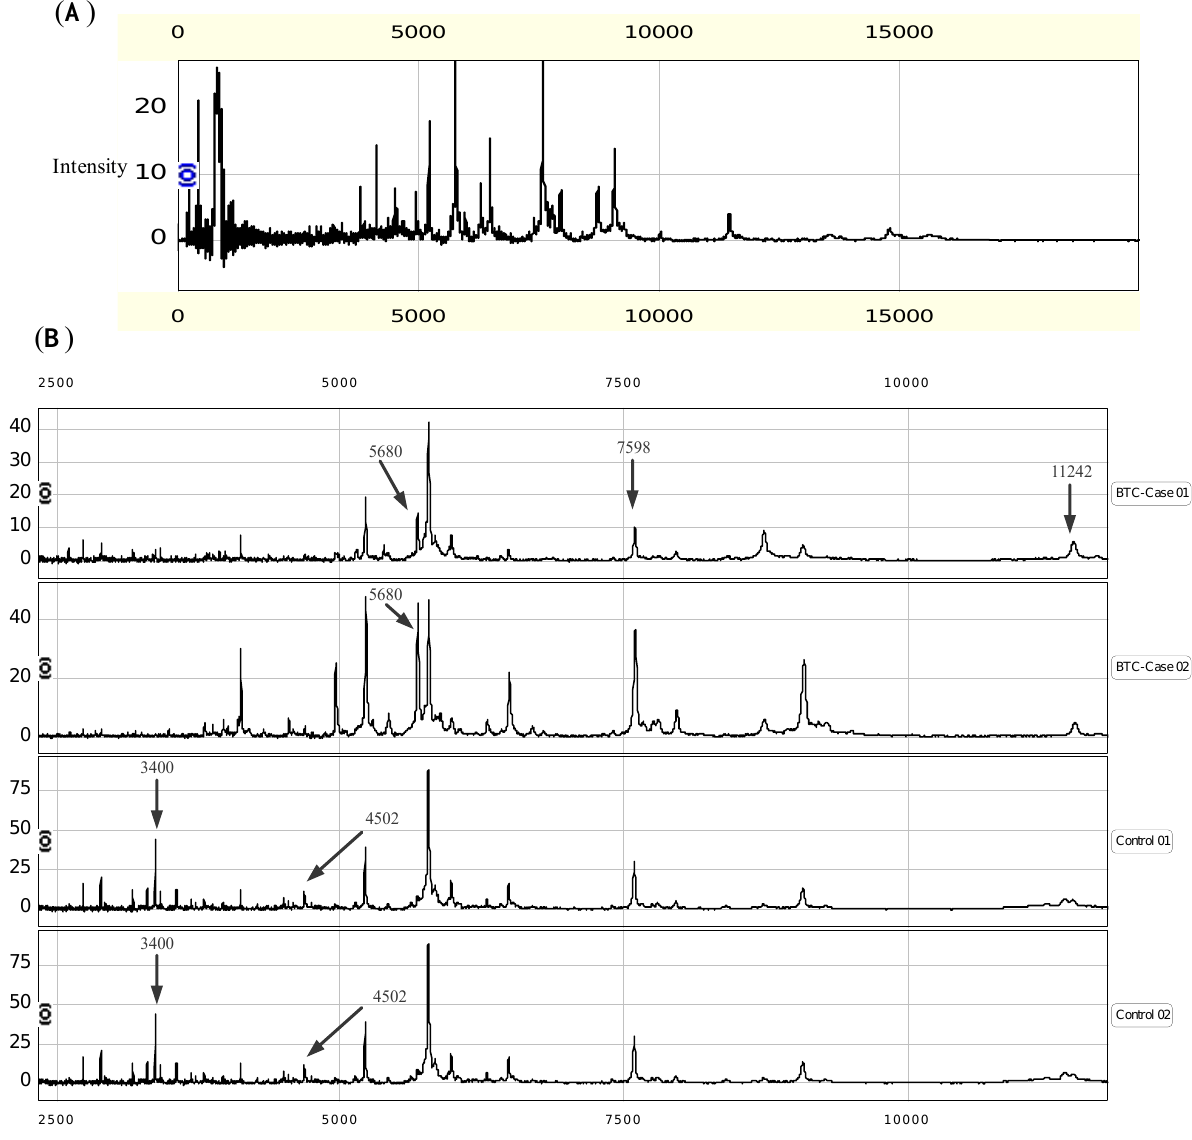
Of a total of 76 protein peaks identified between m/z 3,000 and m/z 15,000, no significant differential peaks were observed between cholelithiasis and healthy controls, and the significant peaks between cholelithiasis and BTCs were almost similar to those between the healthy control and BTCs. Therefore, the two non-cancer groups were combined as one control group for further analysis.